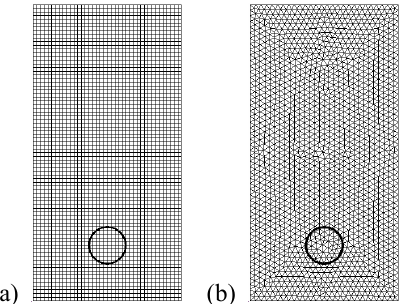
Simulation meshes: (a) structured mesh, (b) unstructured mesh